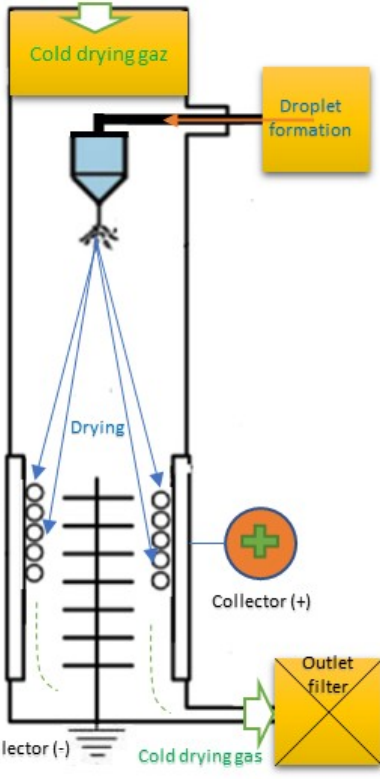
Figure 1. Schematic representation of the drying nanospray principle.